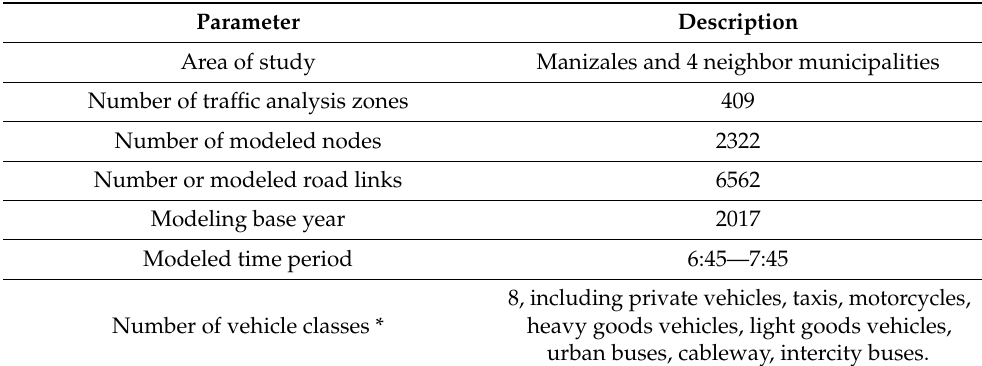
Table 1. Transport modeling parameters and specifications for Manizales,